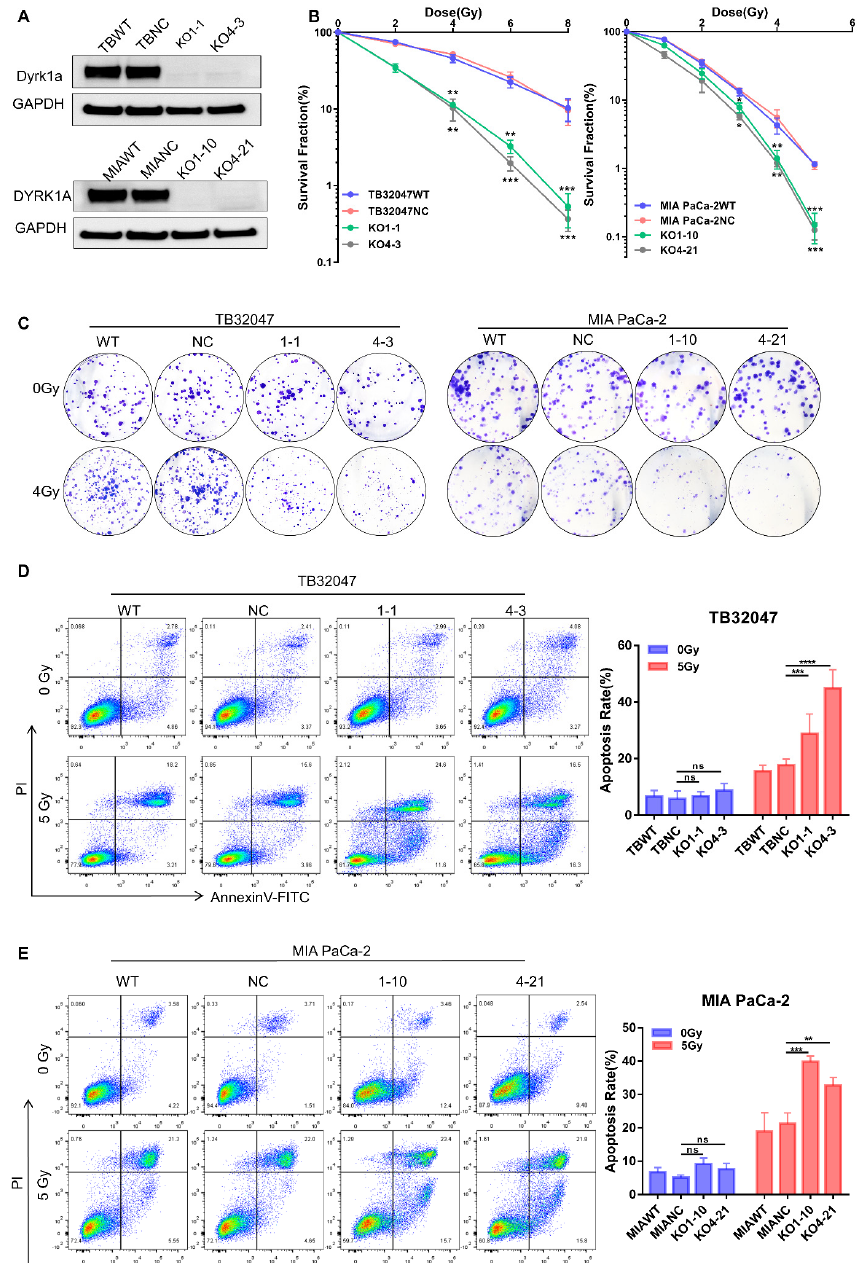
Figure 2. DYRK1A knockout enhances radiotherapy efficacy in pancreatic cancer. ( A ) Western blot of TB32047 and MIA PaCa-2 cells transfected with DYRK1A sgRANs or non-targeting control. ( B ) A clonogenic assay of TB32047 ( left ) and MIA PaCa-2 ( right ) cells with DYRK1A KO and control sgRNA cells was performed after irradiation with different doses of X-rays. The colony numbers were counted and normalized. Data are presented as means of three independent experiments ( n = 3). *, p < 0.05; **, p < 0.01; *** and p < 0.001 by 2-tailed unpaired Student’s t test. ( C ) TB32047 ( left ) and MIA PaCa-2 ( right ) single clones and control cells were treated with different doses of radiation followed by clonogenic assays. Representative images of three independent experiments ( n = 3) are shown. ( D , E ) Flow cytometry-based apoptosis analysis of TB32047 ( D ) and MIA PaCa-2 ( E ) control and DYRK1A KO single clones irradiated with 5 Gy X-rays after 24 h. Representative images of three independent experiments ( n = 3) and statistical analysis are shown. **, p < 0.01; ***, p < 0.001 and ****, p < 0.0001 by 2-tailed unpaired Student’s t test. ns. not